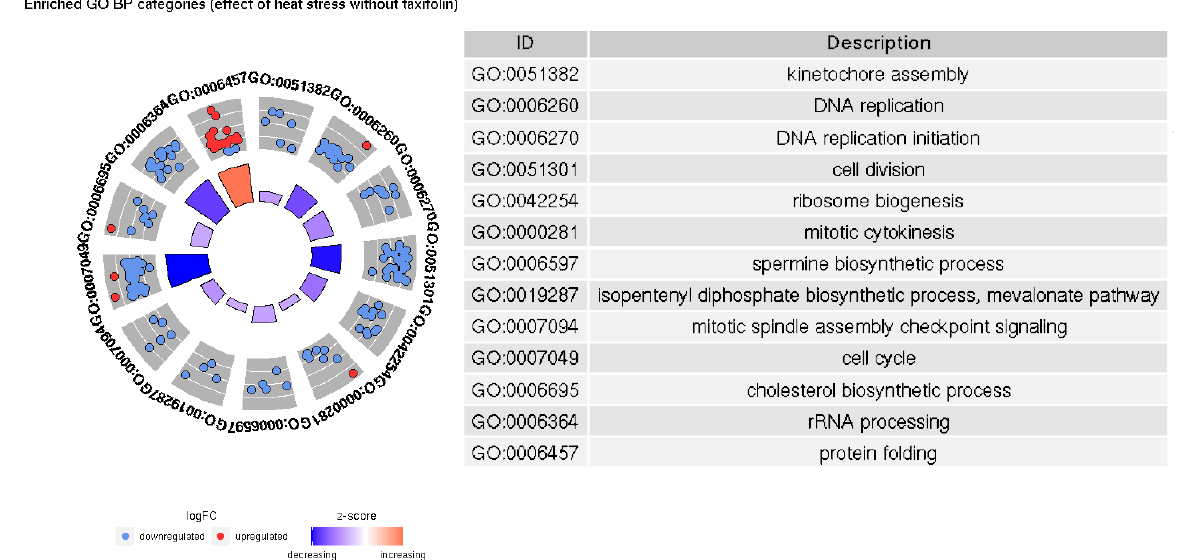
Figure 6. Significantly enriched GO BP categories in the HSnoTyes/HSyesTyes contrast. In both groups, increased temperature causes upregulation of protein folding-related genes and downregulation of genes involved in DNA replication and cell division; how- ever, there are more significantly enriched terms and genes in taxifolin-treated fishes. Our results implying downregulation of cell growth and the activation of heat shock proteins in trout liver due to heat stress are similar to those described in a previous study [39]. However, we do not observe a significant increase in inflammation- and cell death-related categories. Inflammatory processes were documented among the major differentiated GO terms in trout under heat stress [39]. Lewis et al. [42] have also noted the increased expres- sion of kappa-B inhibitor after the stress, presumably to recover the pool of this protein depleted by NF- кB activation. A relatively weak upregulation of kappa-B inhibitor alpha is present in HSyesTyes/HSnoTyes contrast (LFC 1.05, FDR 0.0009), but GO enrichment does not support a significant inflammation-related response. Further, no differential ex- pression of interleukins, TNF- α or most Nod -like receptor genes was observed. The only